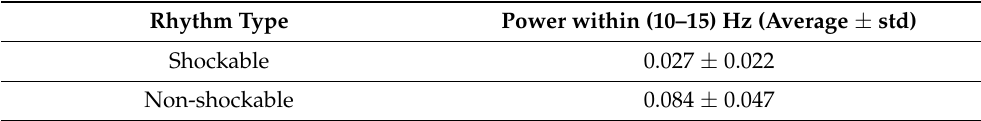
Table 2. Estimated power (watt/Hz) in the development samples for frequencies within (10–15) Hz.